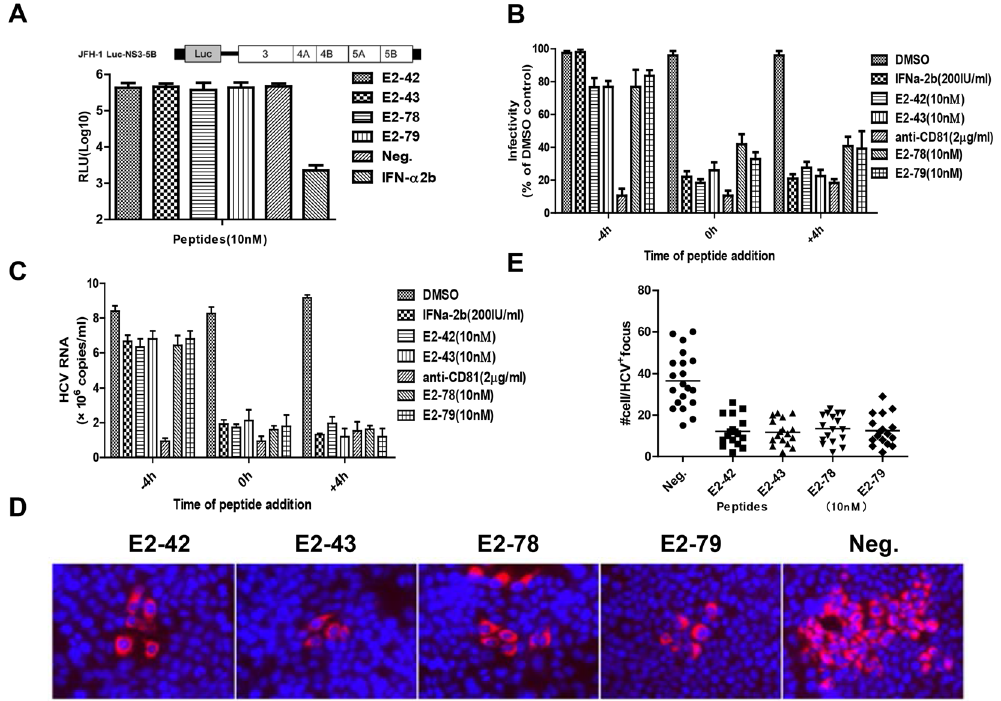
Figure 4. The peptides selectively inhibit cell entry in a virus post-attachment step but do not affect viral RNA replication. ( A ) The inhibitory effect of the peptides on HCV replication in JFH1Luc-NS3-5B replicon cell lines. JFH1Luc-NS3-5B replicon cells were incubated with 10 nM peptides for 2 h, and Gaussia luciferase activity was assayed 72 h later. DMSO-treated cells were used as a negative control. ( B , C ) Peptides were added 4 h before, with or after infection with HCVcc. Peptide or anti-CD81 antibody was added to the cells for 4 h and then was removed before inoculation ( − 4 h), together with virus at the time of inoculation (0 h), or 4 h after virus had been removed by washing ( + 4 h). The cells for − 4 h and 0 h were washed after 4 h incubation and replaced with virus/peptide-free medium, whereas for + 4 h condition the peptides or anti-CD81 antibody remained in the cell cultures throughout the experiment. RNA replication was quantified by Gaussia luciferase assays 72 h after infection ( B ), and HCV RNA copies were assayed by qRT-PCR ( C ). The luciferase results for DMSO, IFN- α 2b and anti-CD81 antibody-treated cells served as controls. ( D , E ) Characterization of the effects of the peptides on HCVcc transmission. Huh7.5/CD81 cells were seeded at 5 × 10 4 /well in 24-well plates the day before infection. The cells were infected with 0.1 FFU/cell mixed with peptides for 2 h, and then the cells were covered with DMEM containing low melting-agarose for culture. After 72 h, the cells were fixed for an immunofluorescence assay. HCV-infected cells were detected by immunofluorescence microscopy ( D ), and the number of HCV- positive cells per focus was enumerated in 20 foci ( E ). The results of DMSO treatment served as a control. Each bar represents the average of triplicate data points, with the standard deviation represented by the error